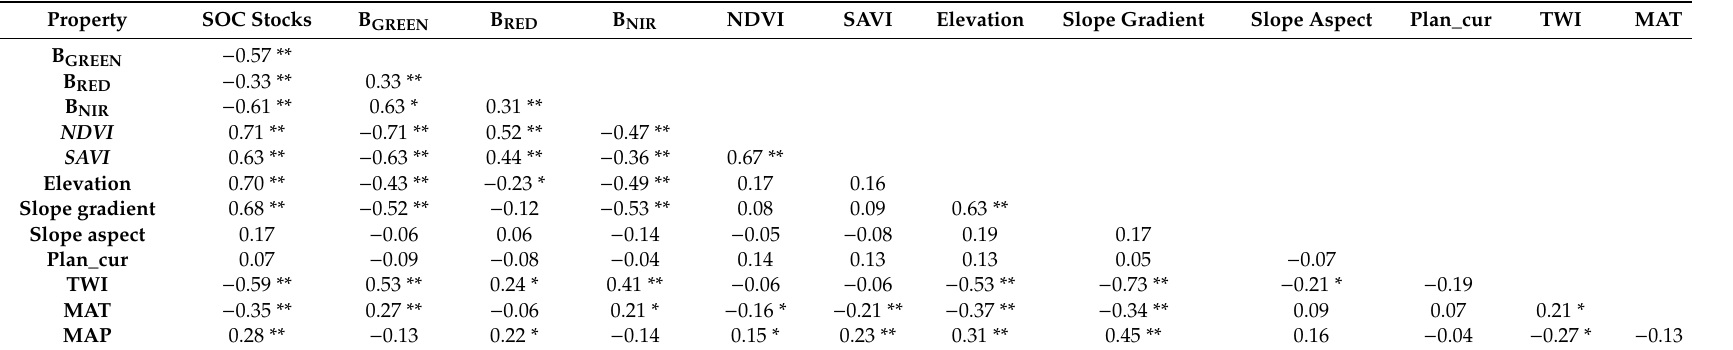
Table 2. Pearson correlation analysis between Ln-transformed SOC stocks and environmental variables based on 236